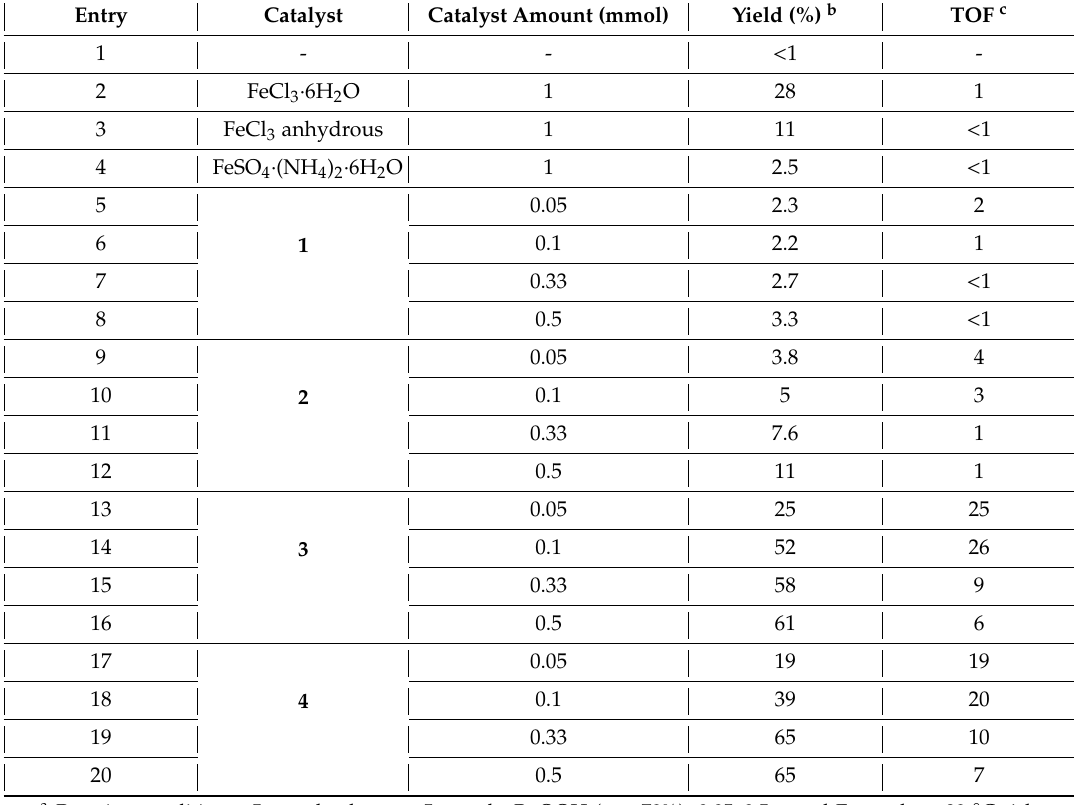
Table 2. MW-assisted oxidation of 1-phenylethanol to acetophenone. a